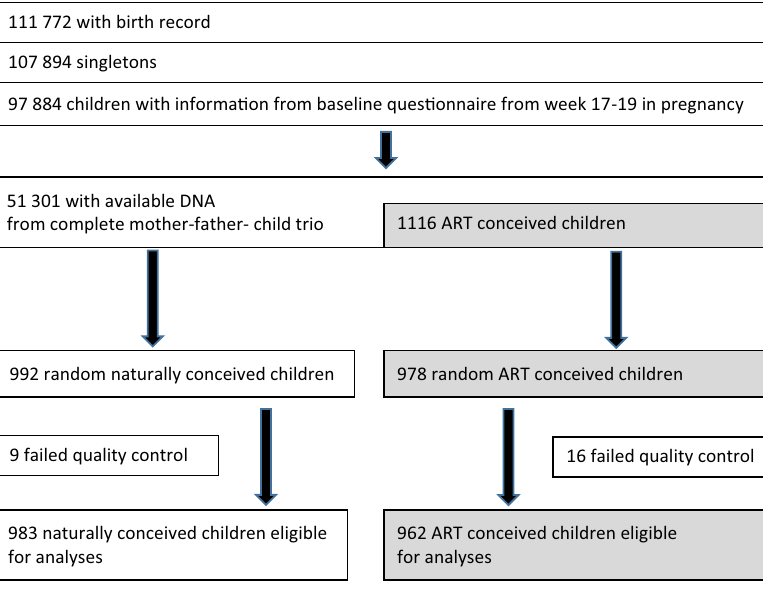
Fig. 1 Selection of study participants. The fl ow chart shows the selection of the eligible study population with 983 naturally conceived newborns and 962 ART conceived newborns in Norwegian Mother, Father and Child Cohort Study.